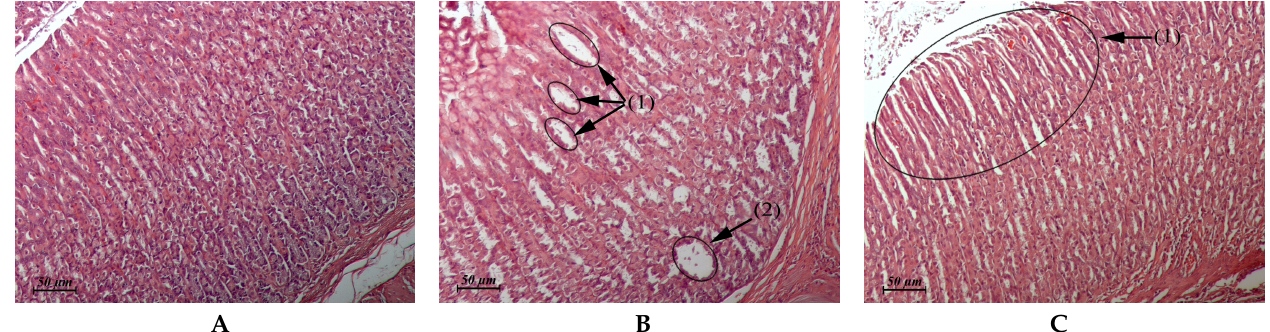
Figure 5. ( A – C ) Rat stomach. ( A ) Untreated control. ( B ) Flavancin, 15 × 10 mg/kg/day, 1 day post- treatment. Sharp expansion of the glands lumen (1) and cyst lined with squamous epithelial cells (2). The parietal cells prevailed in the glands. Destruction of parietal cells in single glands. ( C ) Flavancin, 15 × 10 mg/kg/day, 1 day post-treatment. Deep focal atrophy of the gastric gland epithelium and replacement of the glandular epithelium by the surface epithelium in this area (1) × 20. No pathological changes were observed in other